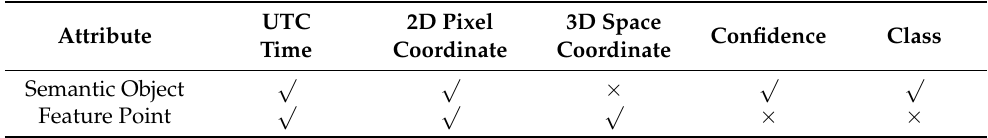
Table 1. The attributes of semantic objects and feature